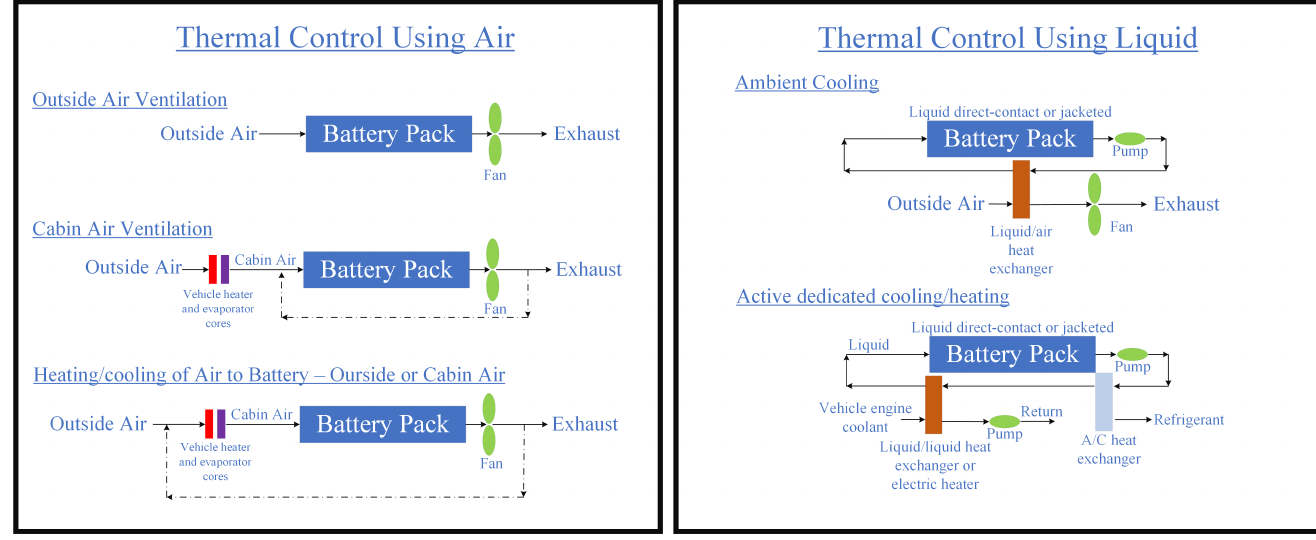
Figure 14. Different cooling methods for Battery Thermal Management. Table 8. Advantages and Disadvantages of Using Air/Liquid for Thermal